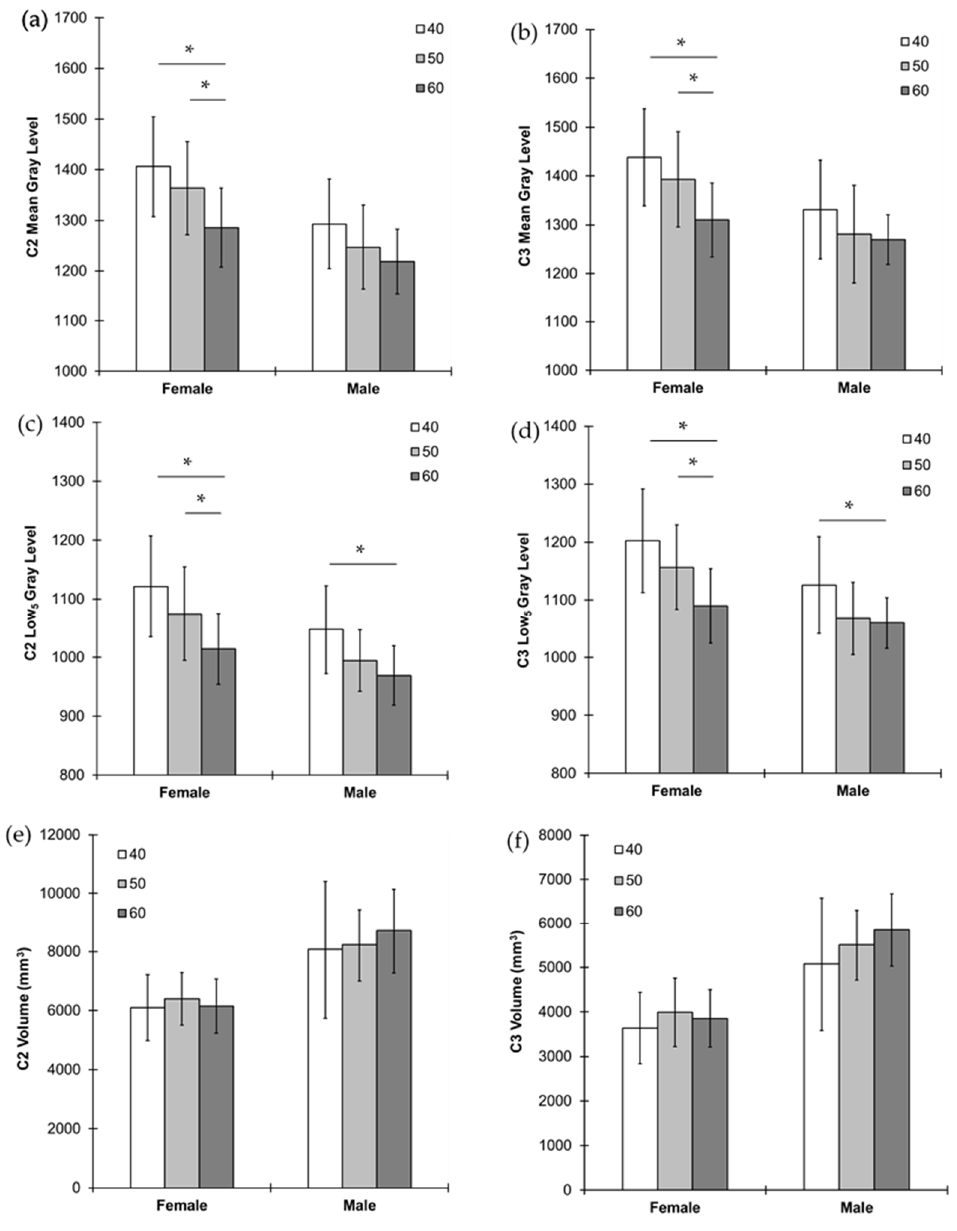
Figure 4. Comparisons between age groups of younger than 50 (40), 50s (50), and older than 50 (60) years in each female and male for ( a ) C2 and ( b ) C3 Mean gray levels, ( c ) C2 and ( d ) C3 Low5 gray levels, and ( e ) C2 and ( f ) C3 volumes. * p < 0.05.